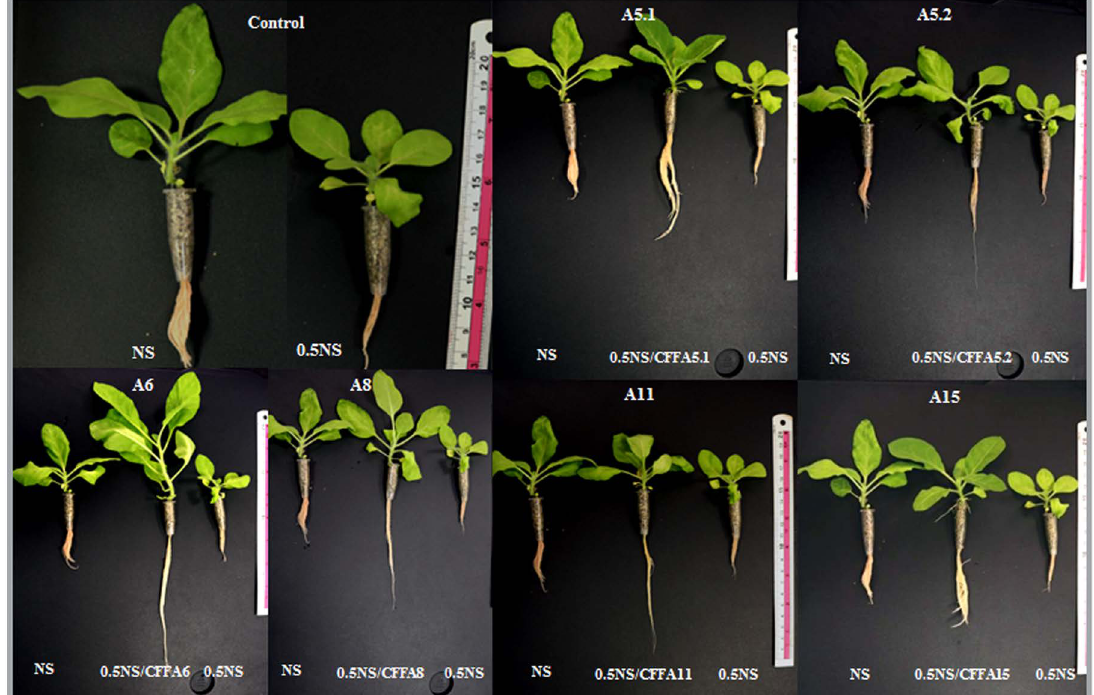
Figure 5. Phenotypes of tobacco seedlings grown in nutrients solution (NS) or (0.5NS) supplied or not with fungal cell-free filtrates (CFF 1/50). ( A5.1 : Byssochlamys spectabilis ; A5.2 : Chaetomium globosum ; A6 : Cephalotheca foveolata ; A8 : Penicillium melinii ; A11 : Alternaria tenuissima ; and A15 : Nigrospora chinensis